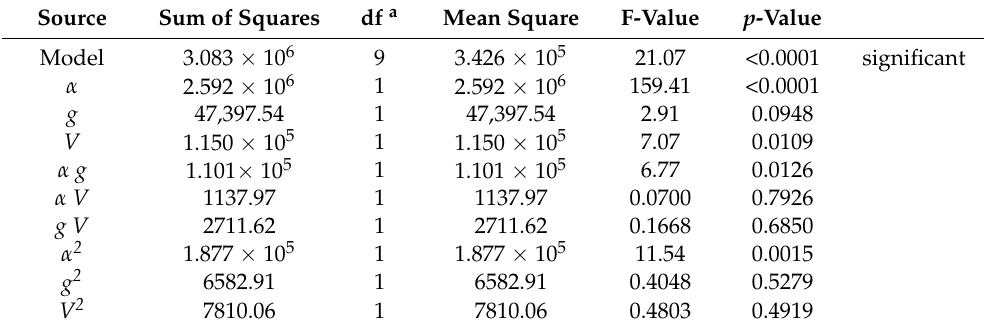
Table 3. ANOVA results. Dependent variable—cutting force— F cc (N).